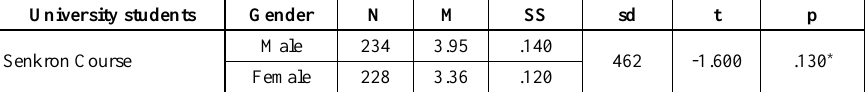
Table 7. Synchronous course status scores of university students according to gender variables University students Gender N M SS sd t p Senkron Course